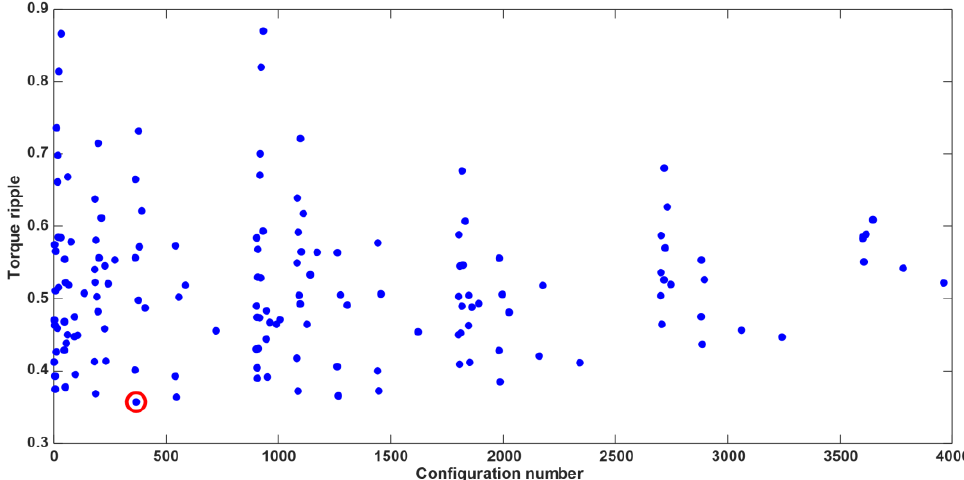
Figure 7. Values of torque ripple for the 154 selected configurations (the minimum value is circled in red).